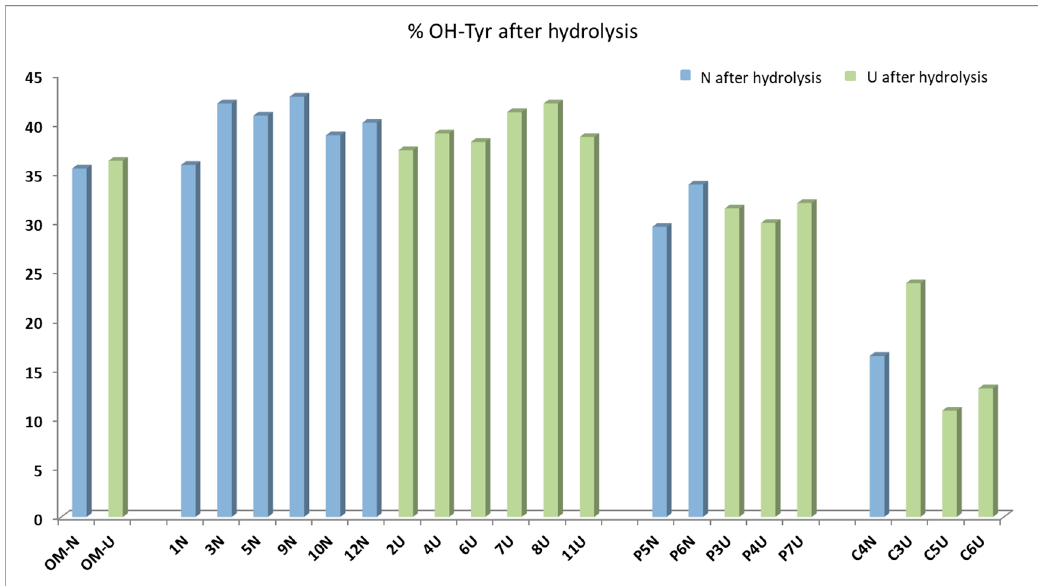
Figure 4. Hydroxytyrosol percentages evaluated after the acidic hydrolysis for the 23 oils and expressed on the sum of tyrosol and hydroxytyrosol.